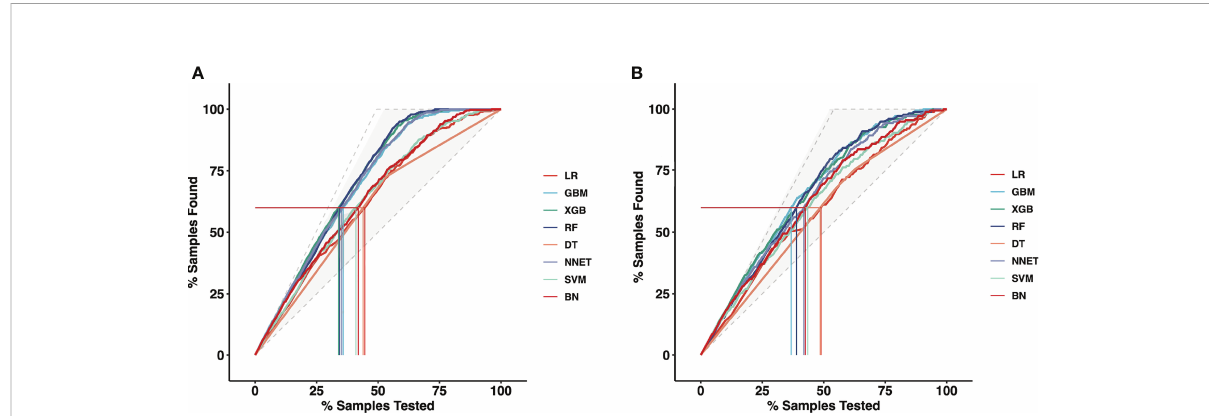
FIGURE 3 The mixed Lift curves of the eight machine learning models for prediction of CLNM. The drawing process of the Lift curve is similar to the ROC curve, the difference is that the Lift value and the robust plane pose change in opposite directions, forming the opposite form of the Lift curve and the ROC curve. (A) The mixed Lift curves in the training cohort; (B) The mixed Lift curves in the validation cohort. CLNM , Central lymph node metastasis; ROC , receiver operating characteristic; LR , Logistic Regression; GBM , Gradient Boosting Machine; XGB , Extreme Gradient Boosting; RF , Random Forest; DT , Decision Tree; NNET , Neural Network; SVM , Support Vector Machine; BN , Bayesian